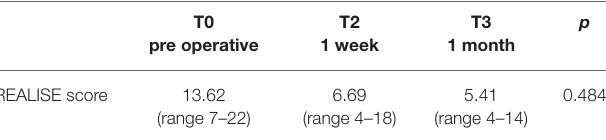
TABLE 4 | REALISE